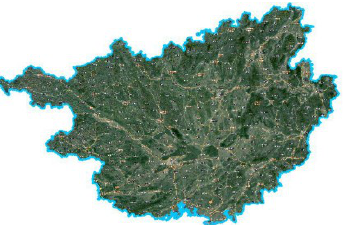
Figure 4. The image of guangzhou district taken by SHP format mask